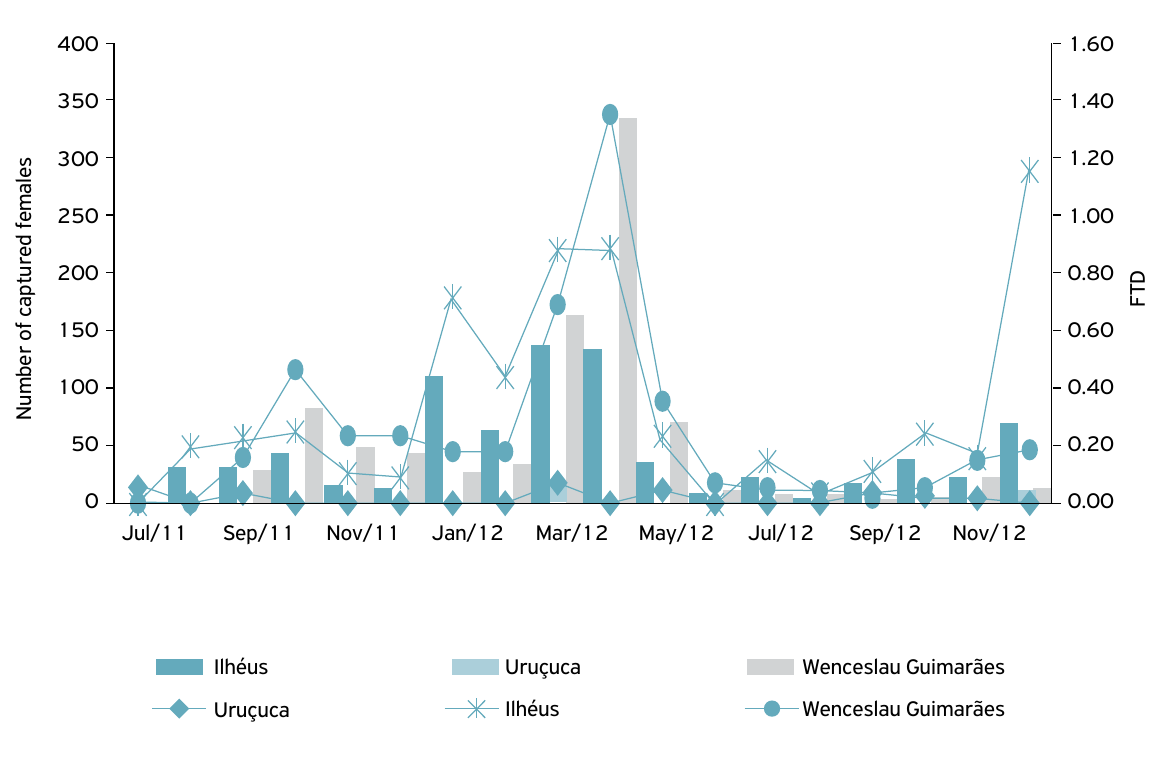
Figure 1. Total number of captured females and fly/trap/day (FTD) index of Anastrepha captured in McPhail traps in Ilhéus, Uruçuca and Wenceslau Guimarães, Bahia, July/2011 –